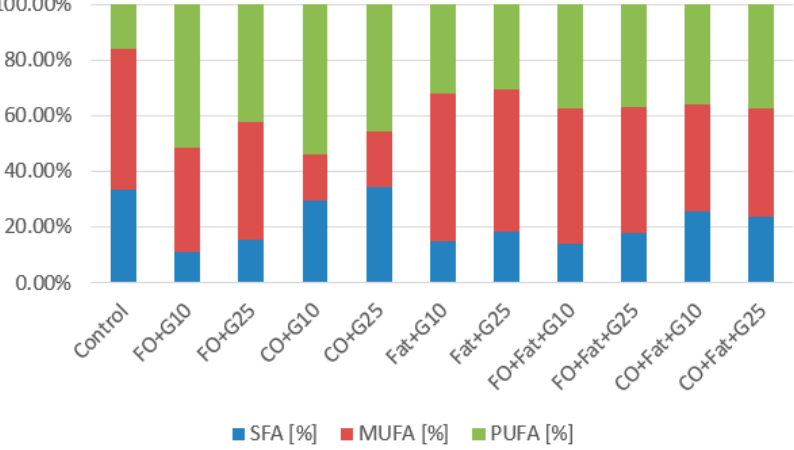
Figure 4. Phase I: Fatty acid production of Rhodotorula kratochvilovae cultivated on a combination of waste lipids and glycerol.